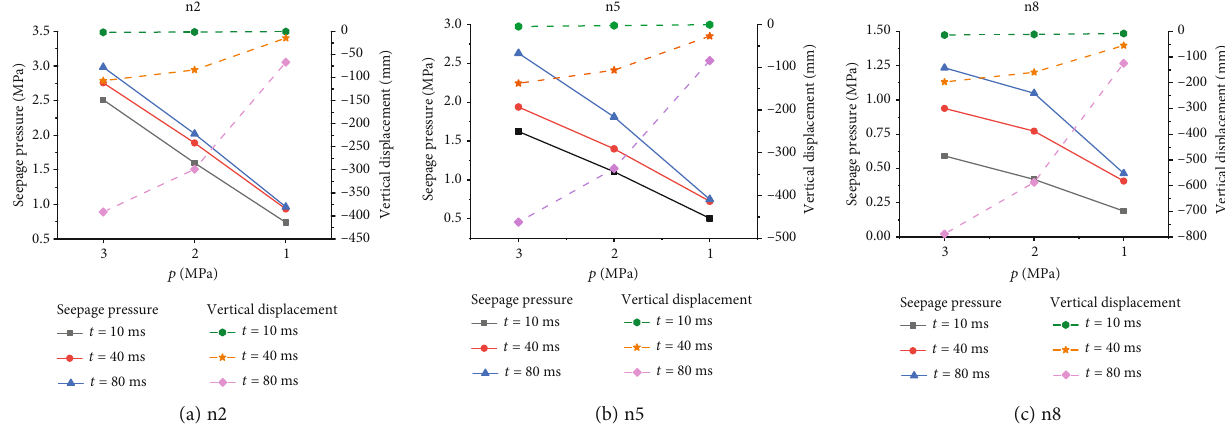
Figure 12: Relationship between seepage pressure and vertical displacement of three measuring points and karst water pressure at di ff erent